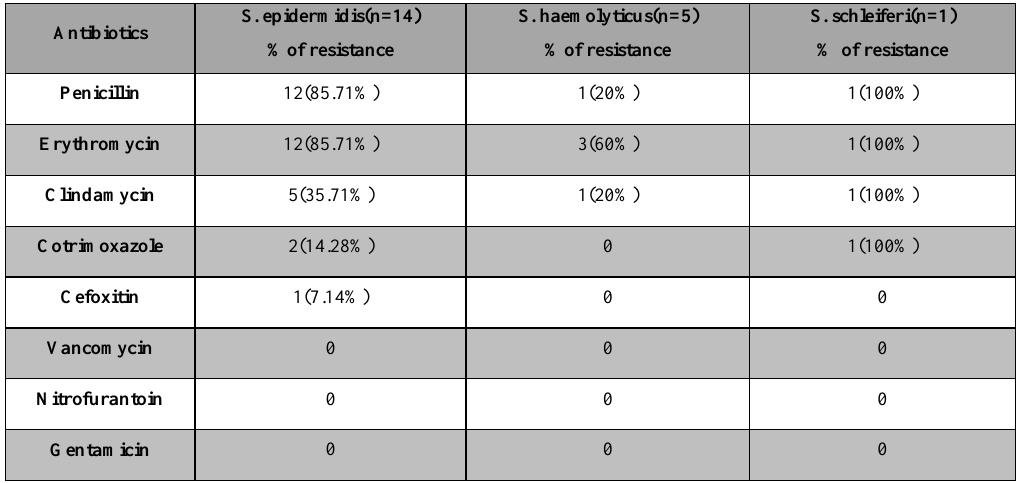
Table 8. Antibiotic resistance pattern of biofilm positive isolates.